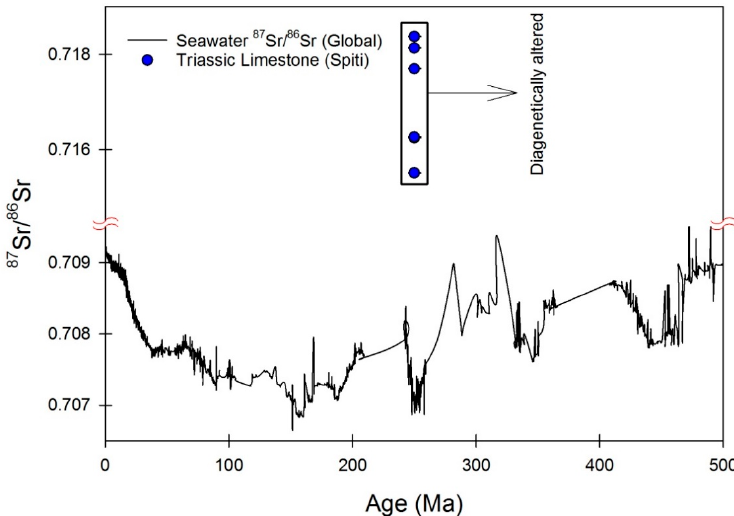
Figure 5. Measured Sr isotopic values of the Induan carbonate samples from the Spiti Valley, India. Data for seawater Sr isotopic trend are from [36].